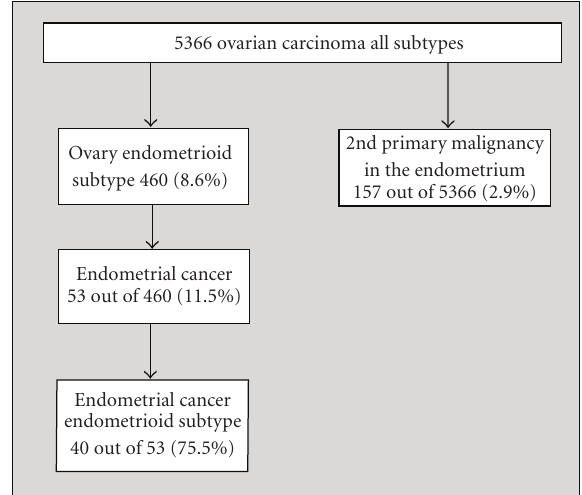
Figure 1: Number of second primary tumors in the endometrium in 460 patients with endometrioid ovary